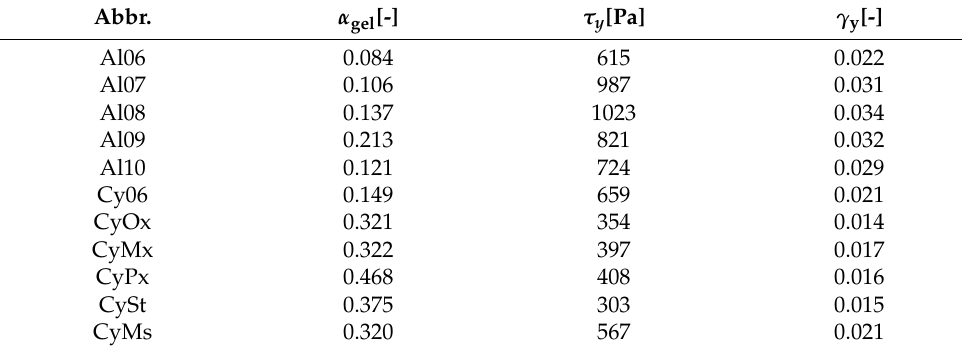
Table 4. Property of 12HSA organogels obtained at v = 80 mmol/L − solvent. Abbr.